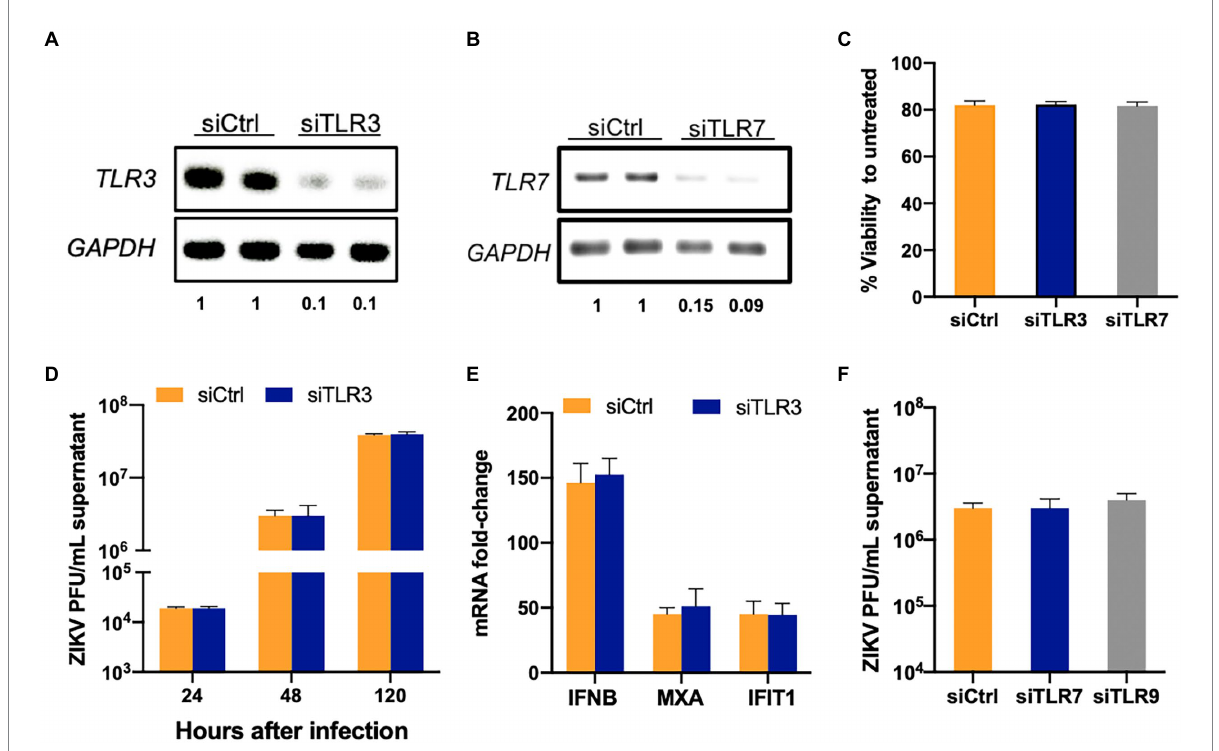
FIGURE 2 TLR3 and TLR7 are not required to induce an antiviral response in SC following ZIKV infection. SC were transfected with either scrambled control (siCtrl) or (A) TLR3 or (B) TLR7 specific siRNA and TLR3 and TLR7 expression was measured at 48 h post-transfection (hpt) by RT-PCR to determine silencing efficiency. The values below the bands indicate the ratio of TLR3 or TLR7 mRNA levels in respective silenced cells compared to siCtrl after normalizing to GAPDH (C) Cell viability was evaluated in siCtrl, siTLR3-and siTLR7 transfected SC at 48 hpt using CellTiter 96 AQueous One Solution kit and the percent cell viability was calculated as compared to untreated cells. (D) TLR3 silenced SC were infected with ZIKV (MOI 1) at 48 hpt and ZIKV titers in the supernatant at different time points were measured by plaque assay. (E) Gene expression of IFNB1, MXA, and IFIT1 was determined at 48 hpi using qRT-PCR. Data was normalized using GAPDH and fold change was calculated compared to mock-infected cells. (F) ZIKV titers measured by plaque assay in TLR7 and TLR9 silenced SC at 48 hpi. Data is presented as mean ± SEM from at least 3–5 independent